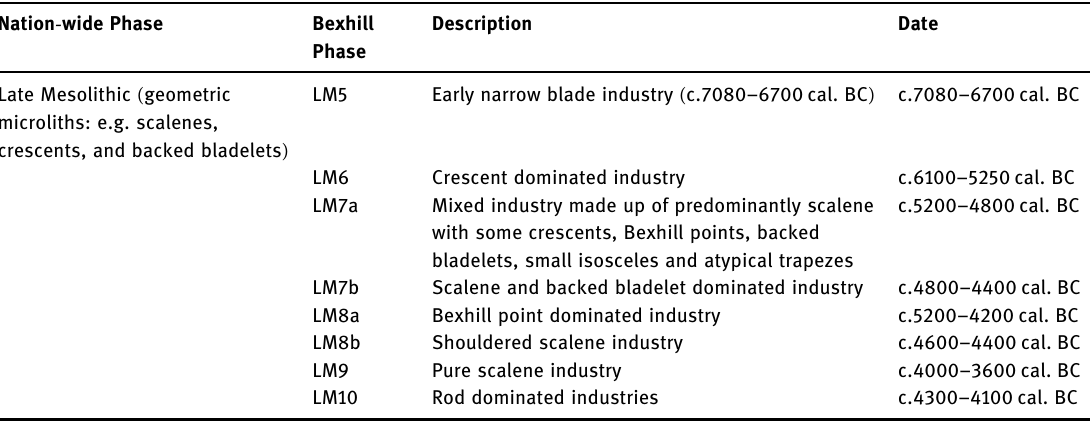
Table 2: Bexhill phases ( Donnelly et al., 2019 )